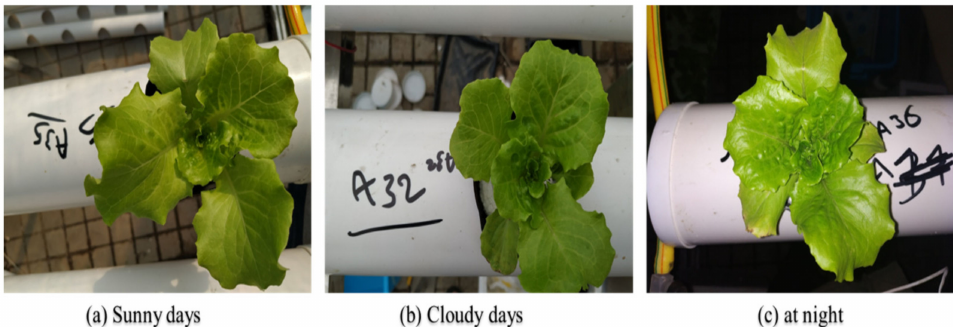
Figure 2. Images captured in different uneven lighting